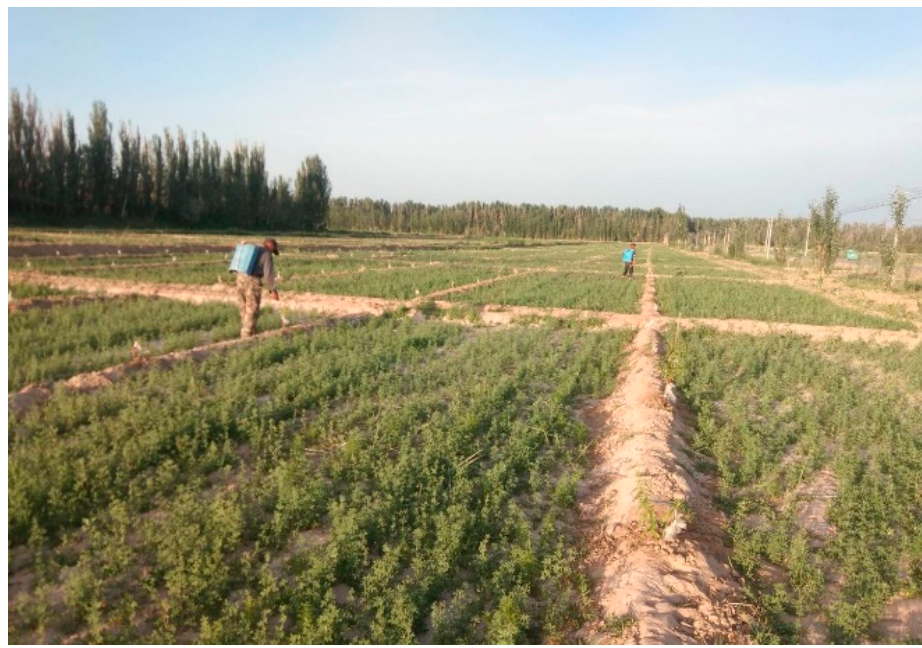
Figure 3. Almond planted in South Xinjiang.